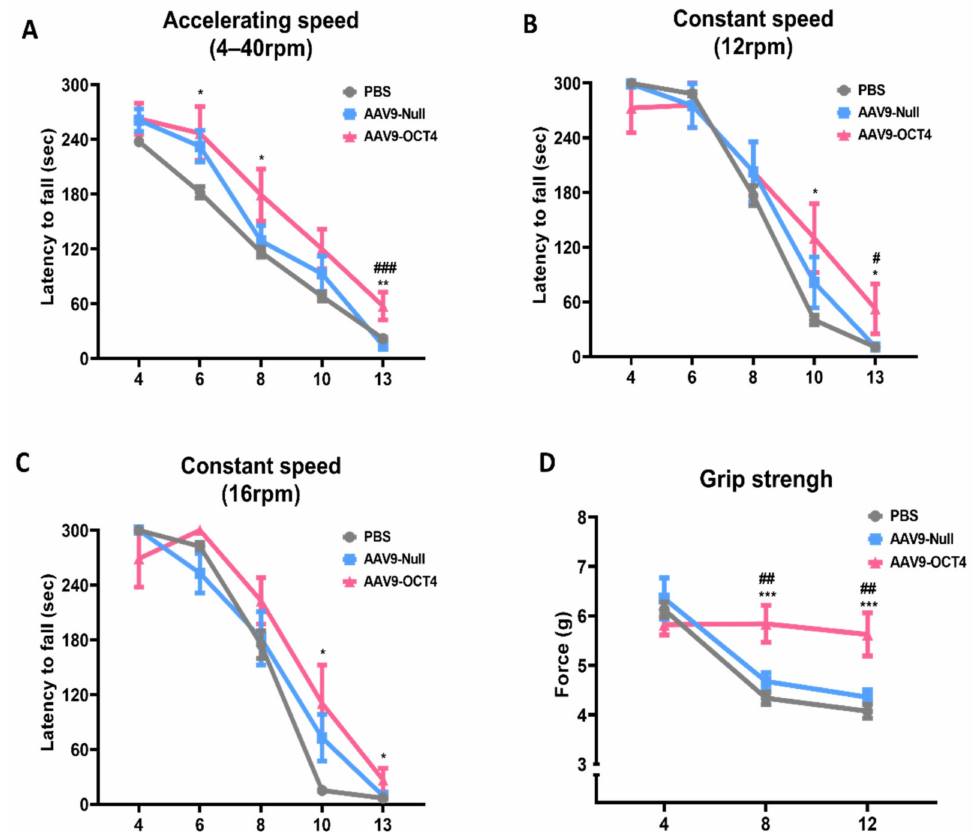
Figure 2. In vivo expression of OCT4 improves behavioral performance in HD mice. ( A ) AAV9-OCT4 group displayed significant improvements compared to the control groups (AAV9-Null and PBS) at 6, 8 and 13 weeks of age in the accelerating rotarod test (4–40 rpm) ( B ) at 10 and 13 weeks of age in the constant rotarod test (12 rpm) ( C ) at 10 and 13 weeks of age in the constant rotarod test (16 rpm) and ( D ) at weeks 8 and 12 in the grip strength test. #,* p < 0.05, ##,** p < 0.01, ***,### p < 0.001. Data in all panels represent mean ± SEM. *PBS vs. AAV9-OCT4, #AAV9-Null vs. AAV9-OCT4. PBS group (N = 10); AAV9-Null (N = 13); AAV9-OCT4 (N =